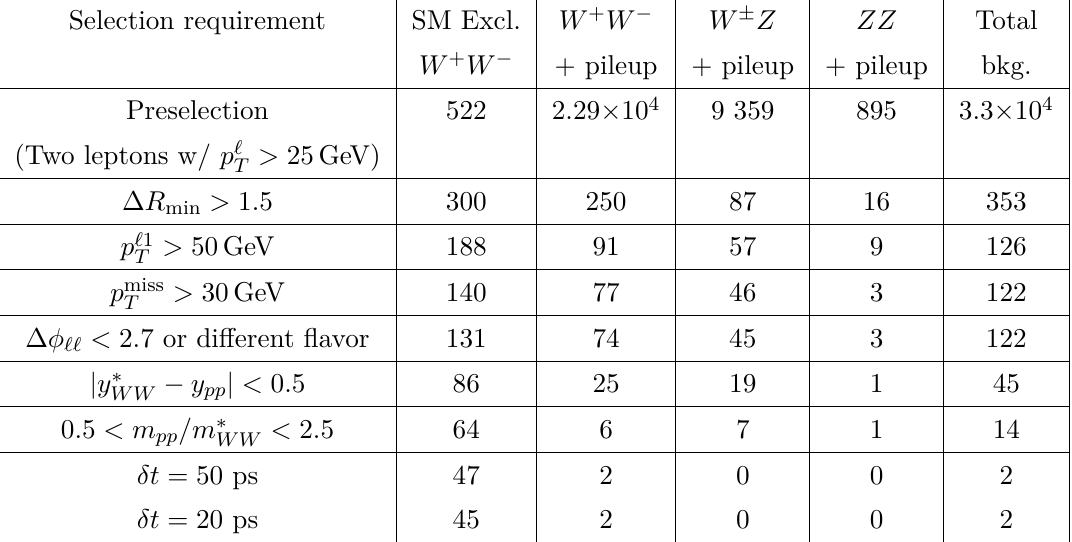
Table 3 . Number of events for 300 fb − 1 after each selection criterion for W + W − exclusive signal (where both W bosons decay leptonically), non-diffractive W + W − + pileup, W ± Z + pileup, ZZ + pileup in leptonic final states. The bottom two rows correspond to the options of time-of-flight difference measurement of the scattered protons with precision of 50 ps or 20